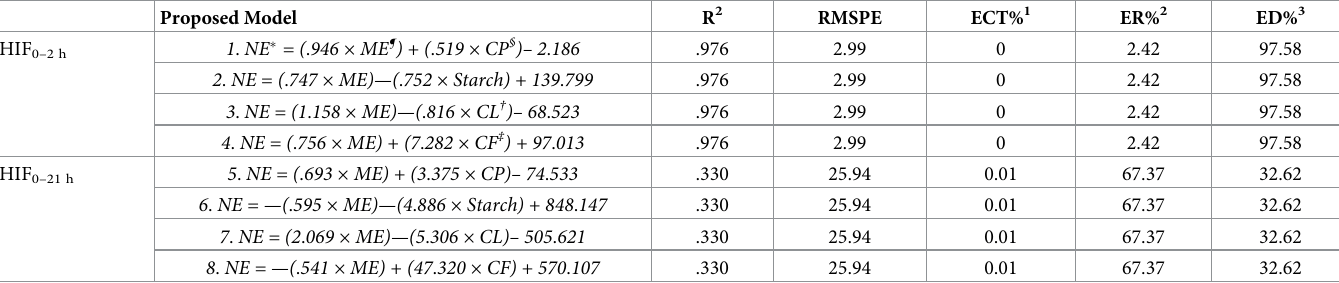
Table 5. Proposed NE models and associated R 2 and RMSPE values using HIF values from 0–2 h and 0–21 h postprandial. Proposed